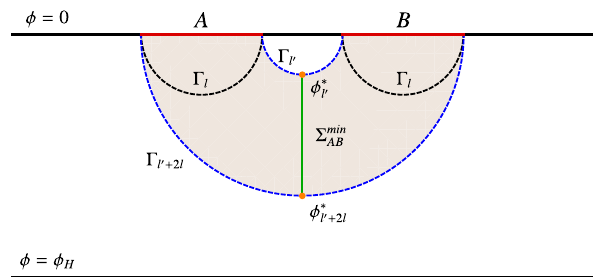
Fig. 7 Thegrayregionshowstheentanglementwedgedualto ρ AB and (cid:13) min ,thegreencurve,istheentanglementwedgecrosssectionbetween AB subregions A and B. Here we only show the connected configuration. For disconnected configuration the entanglement wedge cross section vanishes E w = 0. The RT-surfaces, the dashed curves, are denoted by